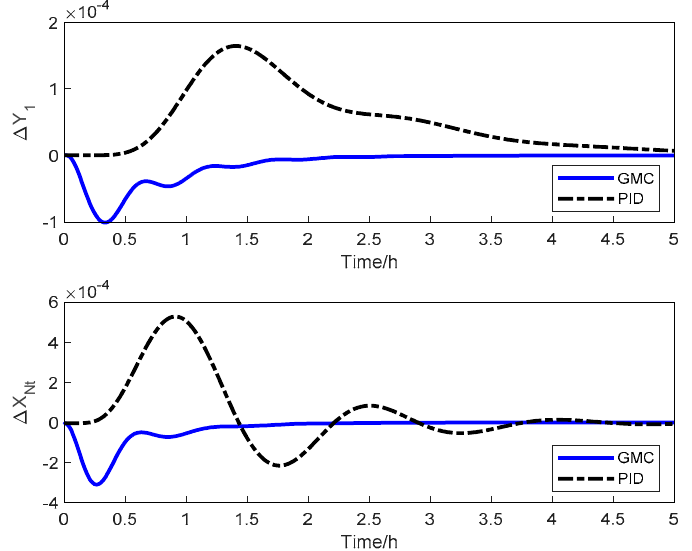
Figure 18. Response curve of controlled variable when the feed composition Z f +20% in Case 2.